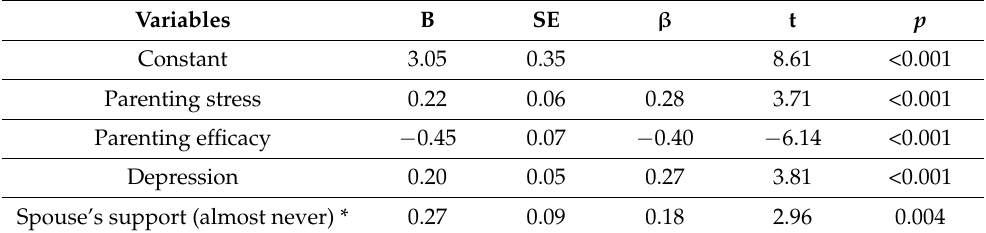
Table 4. Affecting factors on the subjects’